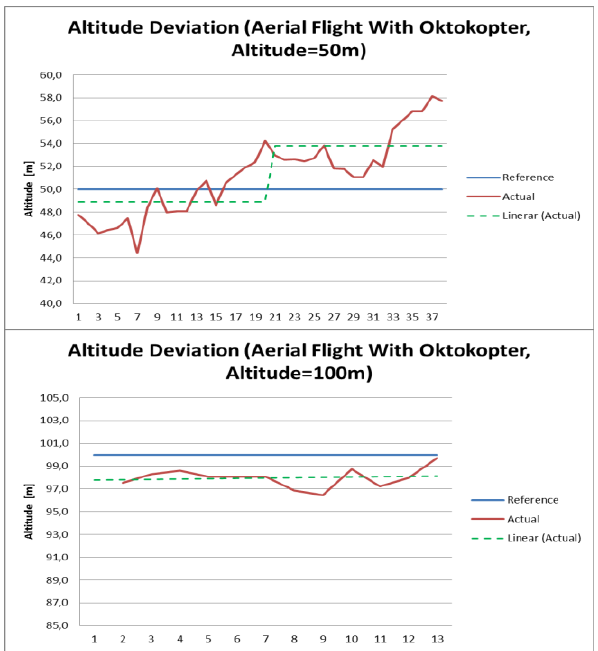
Figure 10. Comparison of reference and realised altitude during aerial flight